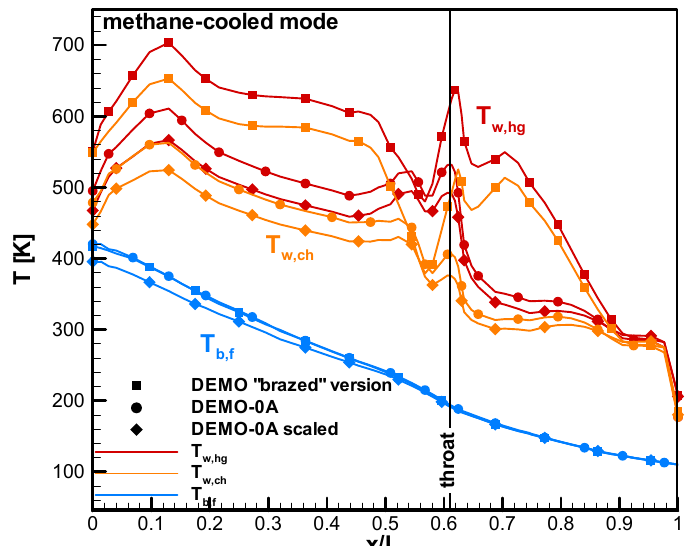
Figure 13. Methane-cooled mode: axial profiles of hot gas walls, channel bottom walls and fluid bulk temperature.